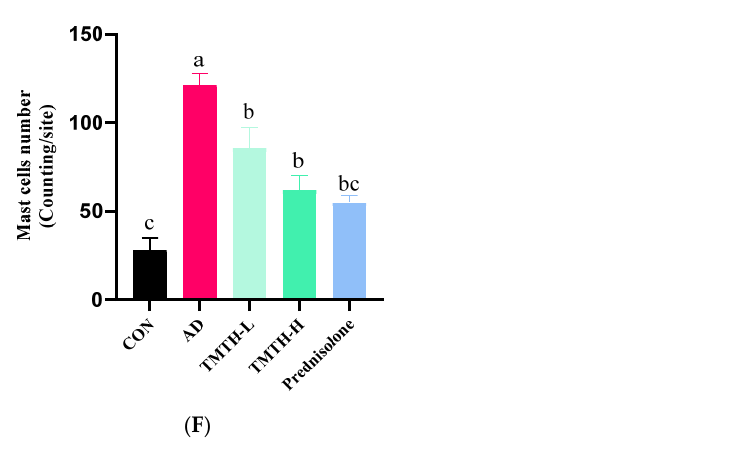
Figure 6. Effects of Tenebrio molitor trypsin hydrolysate (TMTH) on the histopathological characteristics of DNCB-induced mice. ( A ) H&E staining photographs of cross and longitudinal sections of dorsal skin at ×100 magnification (500 µm; Scale bar). ( B ) Hematoxylin and eosin (H&E) staining photographs of cross and longitudinal sections of dorsal skin at ×200 magnification (100 µm; Scale bar). ( C ) Dermal thickness of control group, AD group, and DNCB-induced mice administered TMTH and prednisolone group. ( D ) Epidermal thickness of control group, AD group, and DNCB-induced mice treated with TMTH and prednisolone group. ( E ) Toluidine blue staining photographs of dorsal skin of control group, AD group, and DNCB-induced mice treated with TMTH and prednisolone group at ×100 magnification (Scale bar, 500 µm). ( F ) Mast cell number of control group, AD group, and DNCB-induced mice treated with TMTH and prednisolone group. The significant values are expressed in different letters based on the Tukey’s multiple comparisons test results ( p < 0.05). CON: control group; AD: DNCB-treated group; TMTH-L: mice challenged with 1% 2,4-dinitrochlorobenzene (DNCB) treated with 1 mg/kg TMTH; TMTH-H; mice challenged with 1% DNCB treated with 10 mg/kg TMTH; Prednisolone: mice challenged with 1% DNCB treated with 3 mg/kg prednisolone.